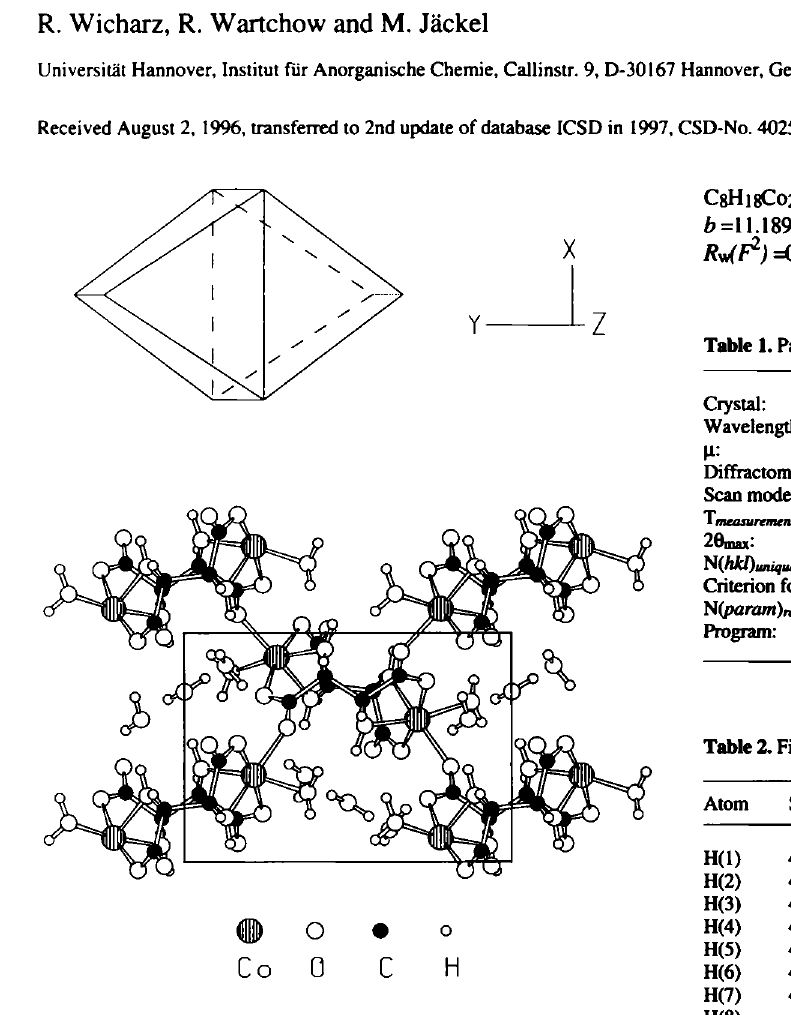
Table 1. Parameters used for the X-ray data collection